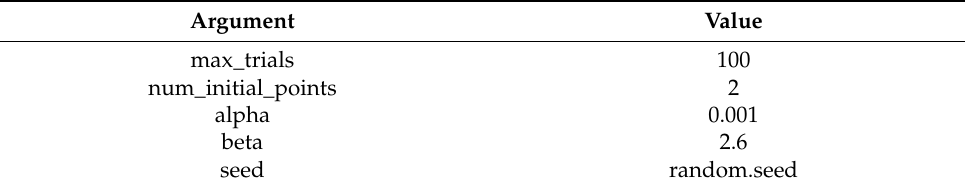
Table 4. Values assigned to the arguments of the Keras Bayesian optimization